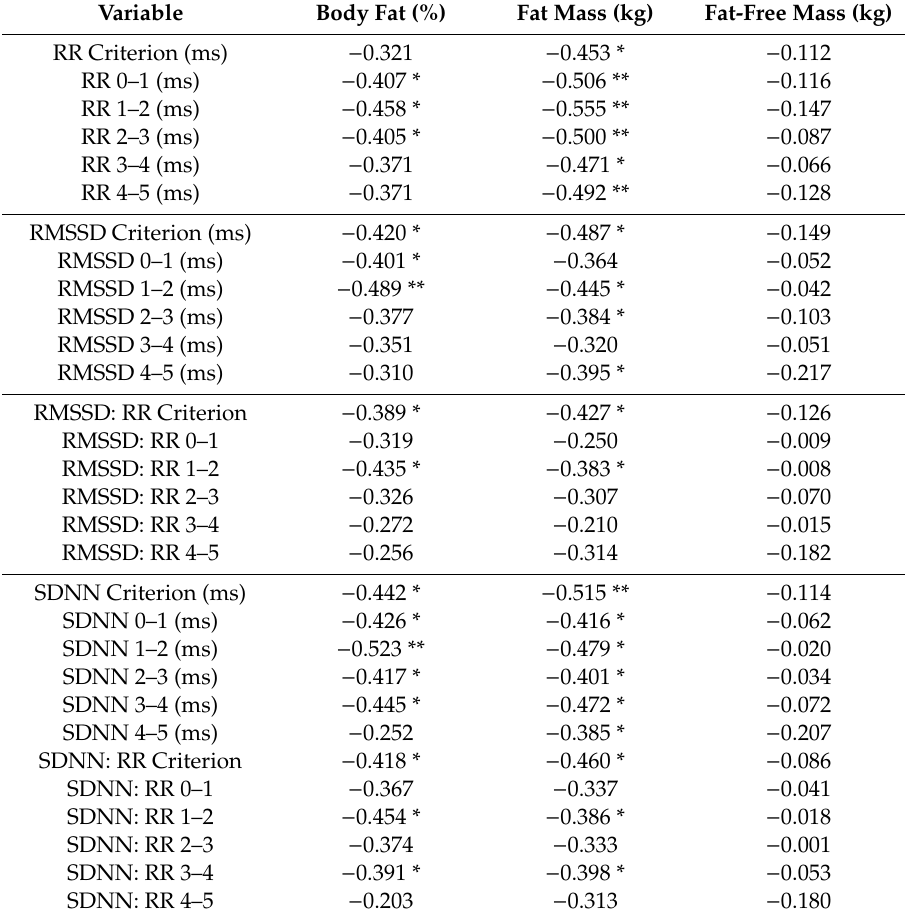
Table 2. Correlation coe ffi cients between heart rate variability parameters and markers of fitness and body